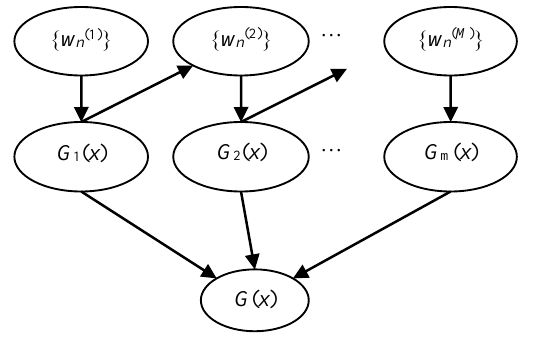
Figure 5. AdaBoost structure diagram